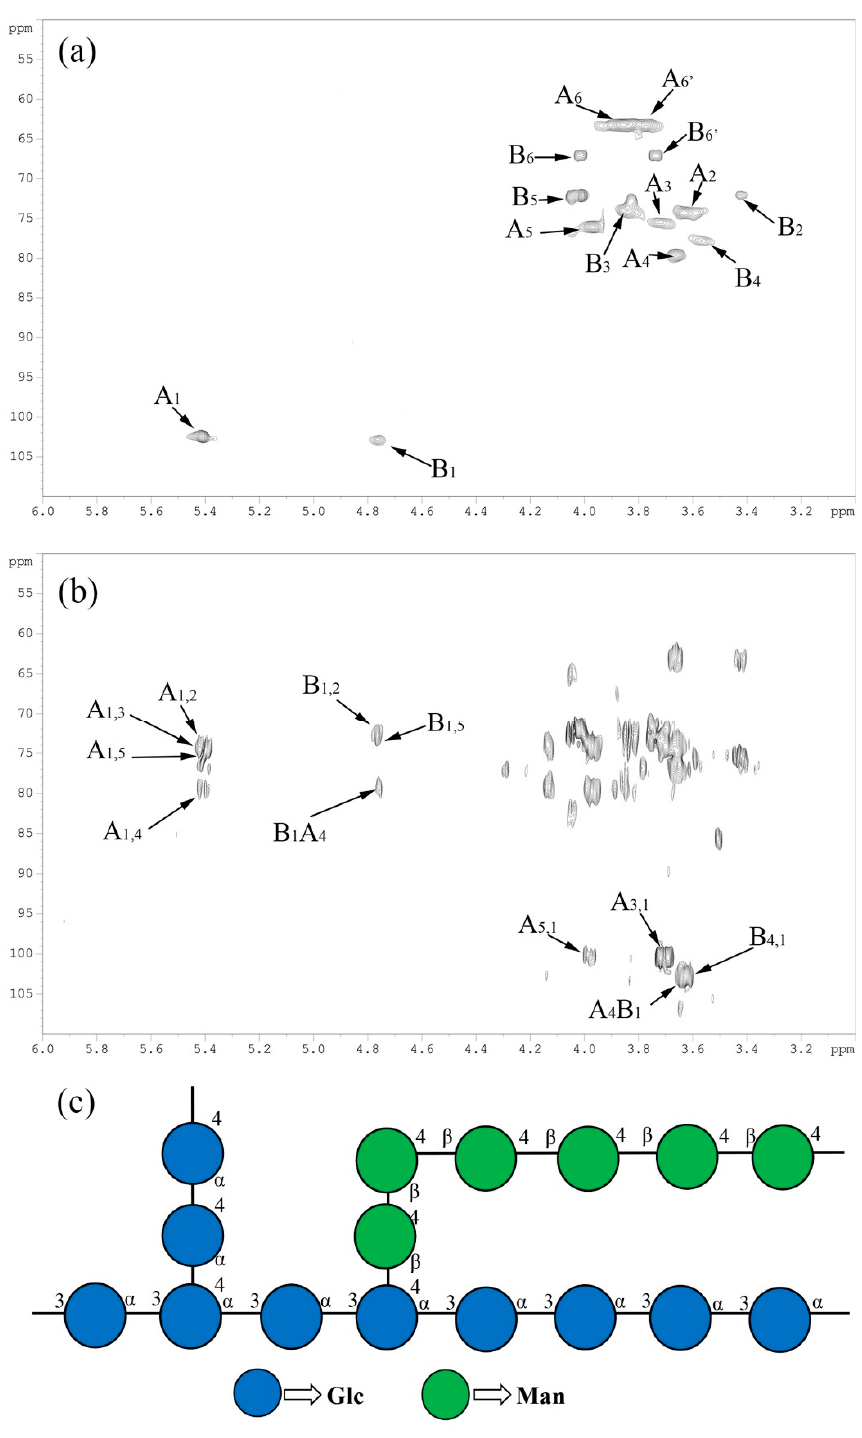
Figure 4. The 2D HSQC ( a )/HMBC ( b ) spectra and possible chemical structure ( c ) of DOPs.